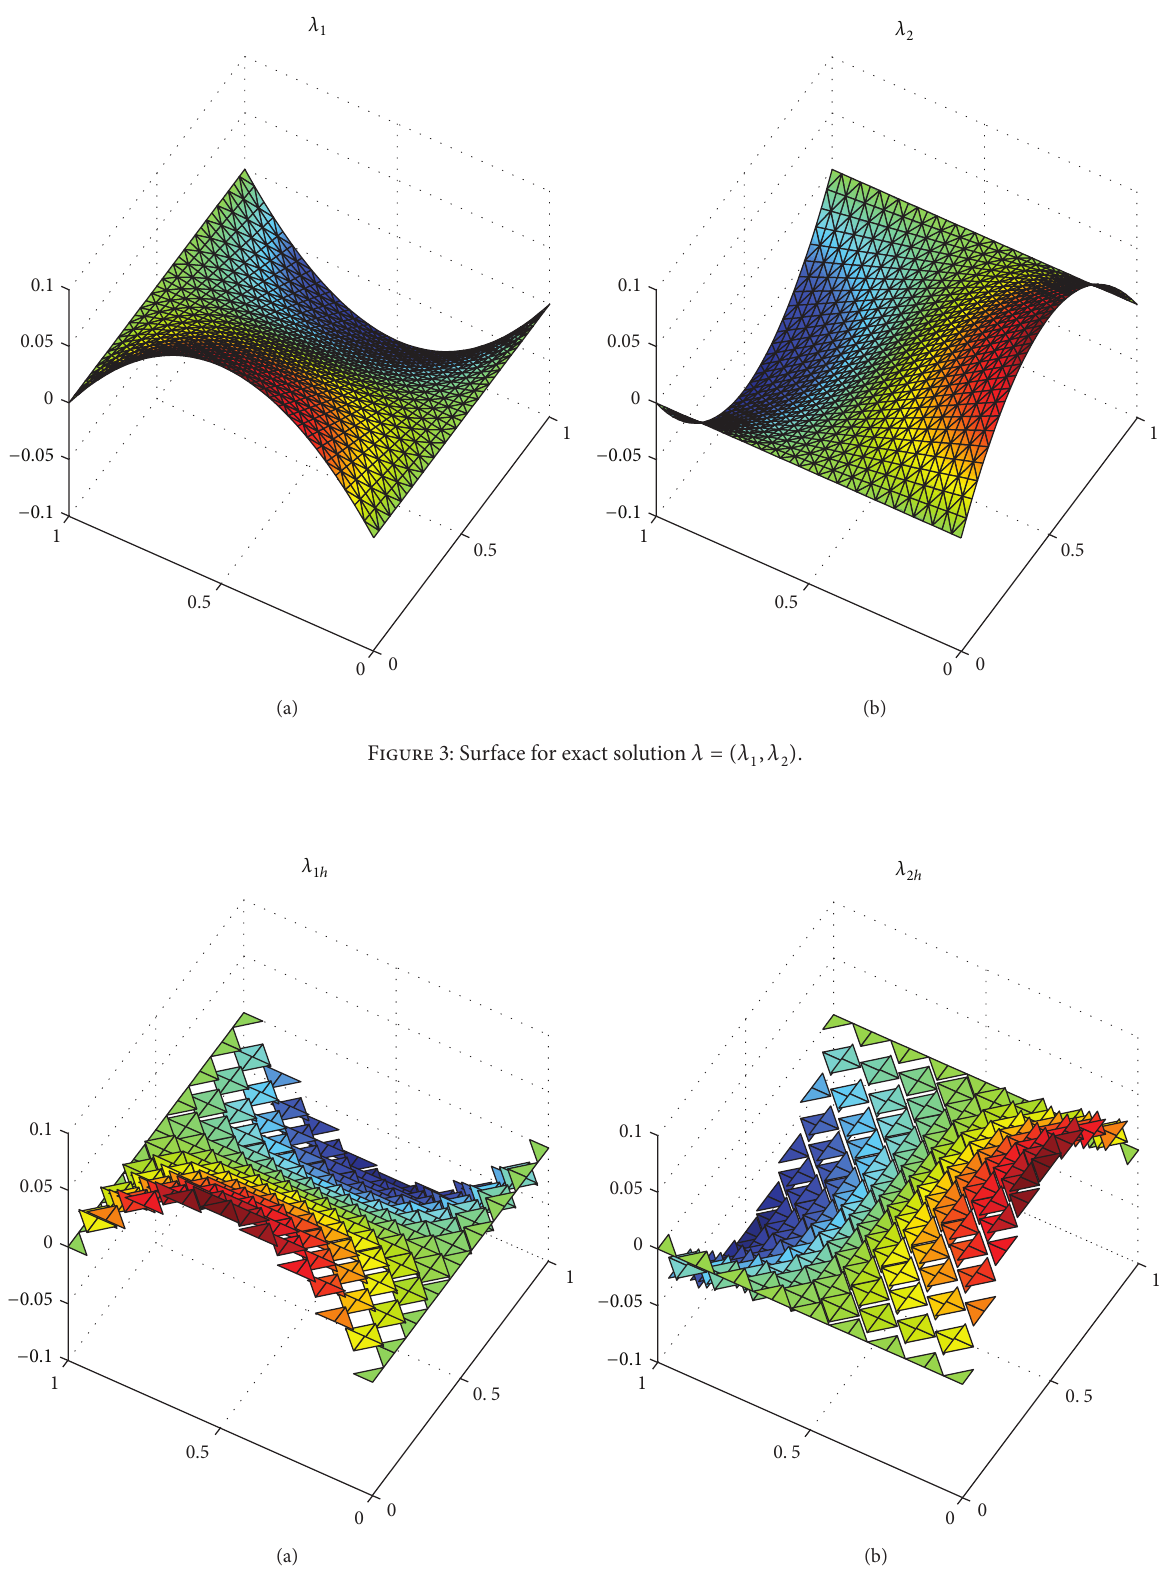
Figure 4: Surface for numerical solution 𝜆 ℎ = (𝜆 1ℎ , 𝜆 2ℎ )